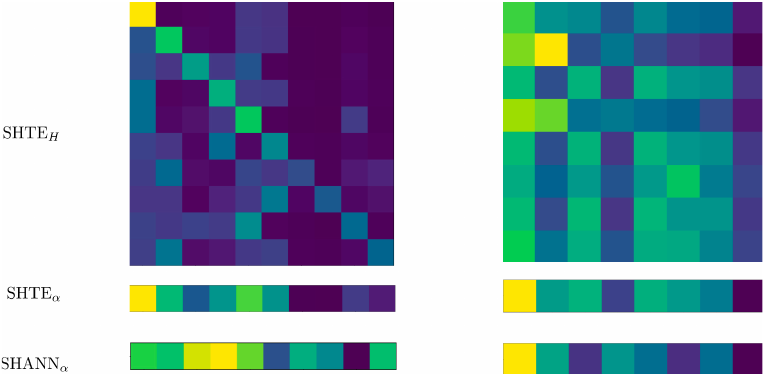
Figure 9. Attentions for the NewsRoom and CNN/DailyMail test examples for both SHTE and